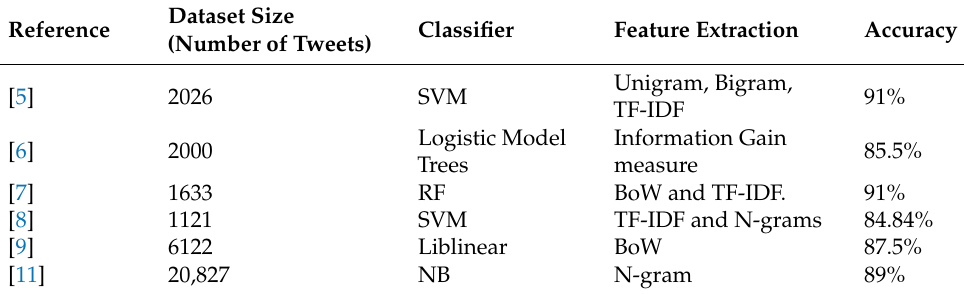
Table 1. Summary of related research applied models and